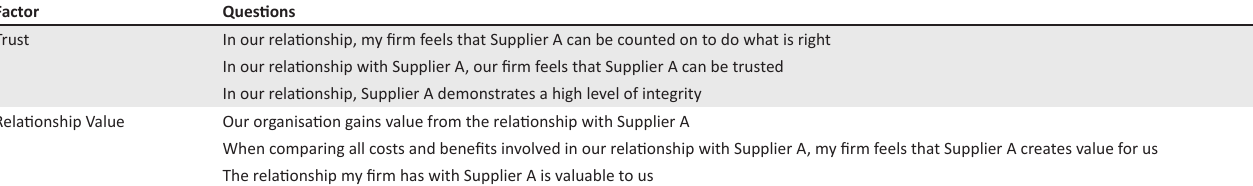
TABLE 3: Questions relating to trust and relationship